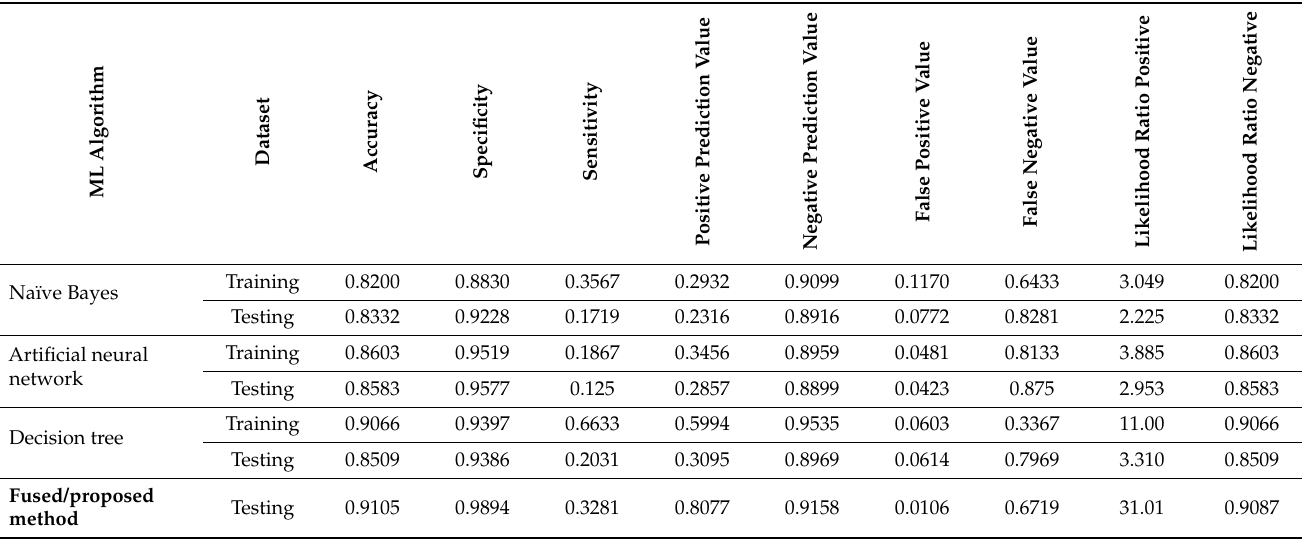
Table 10. ML Algorithm